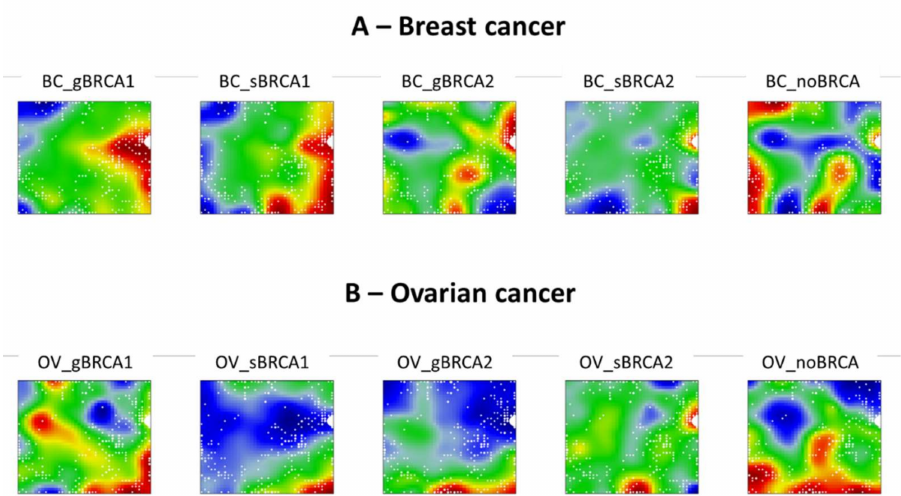
Figure 8. Olaparib gene signature distribution on the transcriptome landscapes in the breast ( A ) and ovarian ( B ) cancers. White dots represent Olaparib-related genes mapped to the corresponding metagenes on a given transcriptome landscape. It can be noted that signature genes are predominantly mapped on or around upregulated (red) spots on each portrait. This suggests different action effects of Olaparib depending on the disease, mutation type, and gene